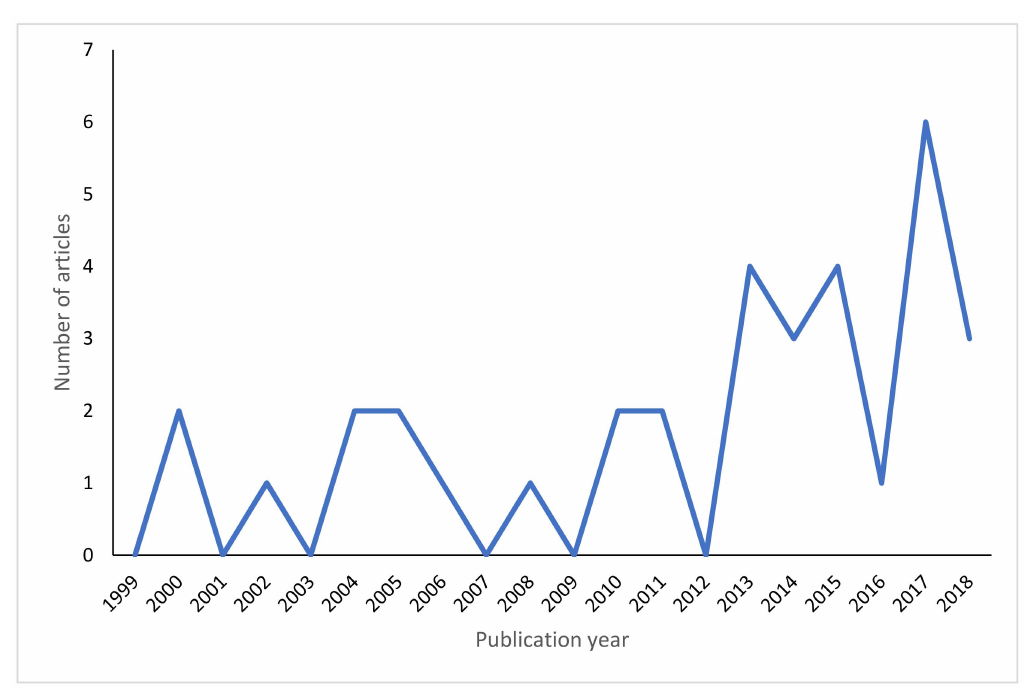
Figure 1. Number of sentience papers published between